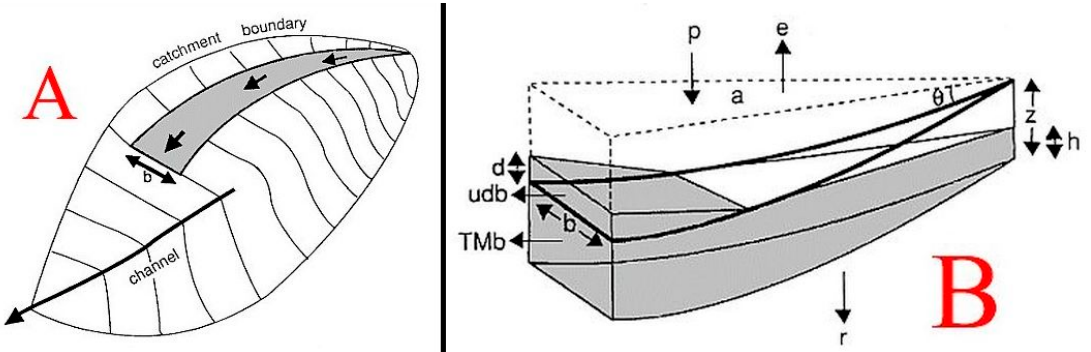
Figure 8. Sketch of hydrological model: ( A ) plan view and ( B ) cross section of a draining area a across a contour of length b. ( B ) The grey volume is the shallow sub-surface flow TMb and the saturation overland flow udb (not calculated by the model). p: precipitation; e: evapotranspiration; r: deep drainage; q: effective rainfall (q = p − e − r); h: vertical depth of the saturated sub-surface flow; z: vertical depth of the failure plane; T: transmissivity; M: sin θ ; θ : slope angle. Mettma Ridge study site